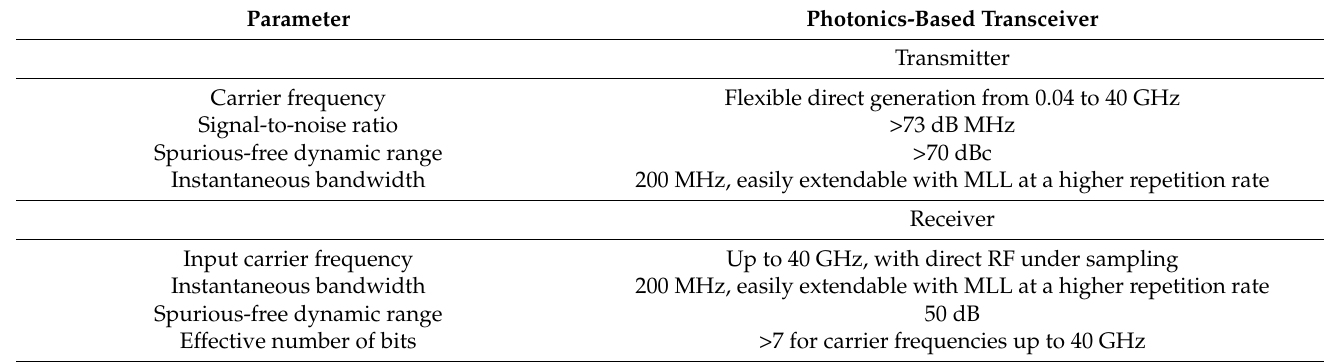
Table 1. Performance requirements of a photonics-based radar transceiver (Adapted with permis-sion from Ref [22]. Copyright 2014, Springer